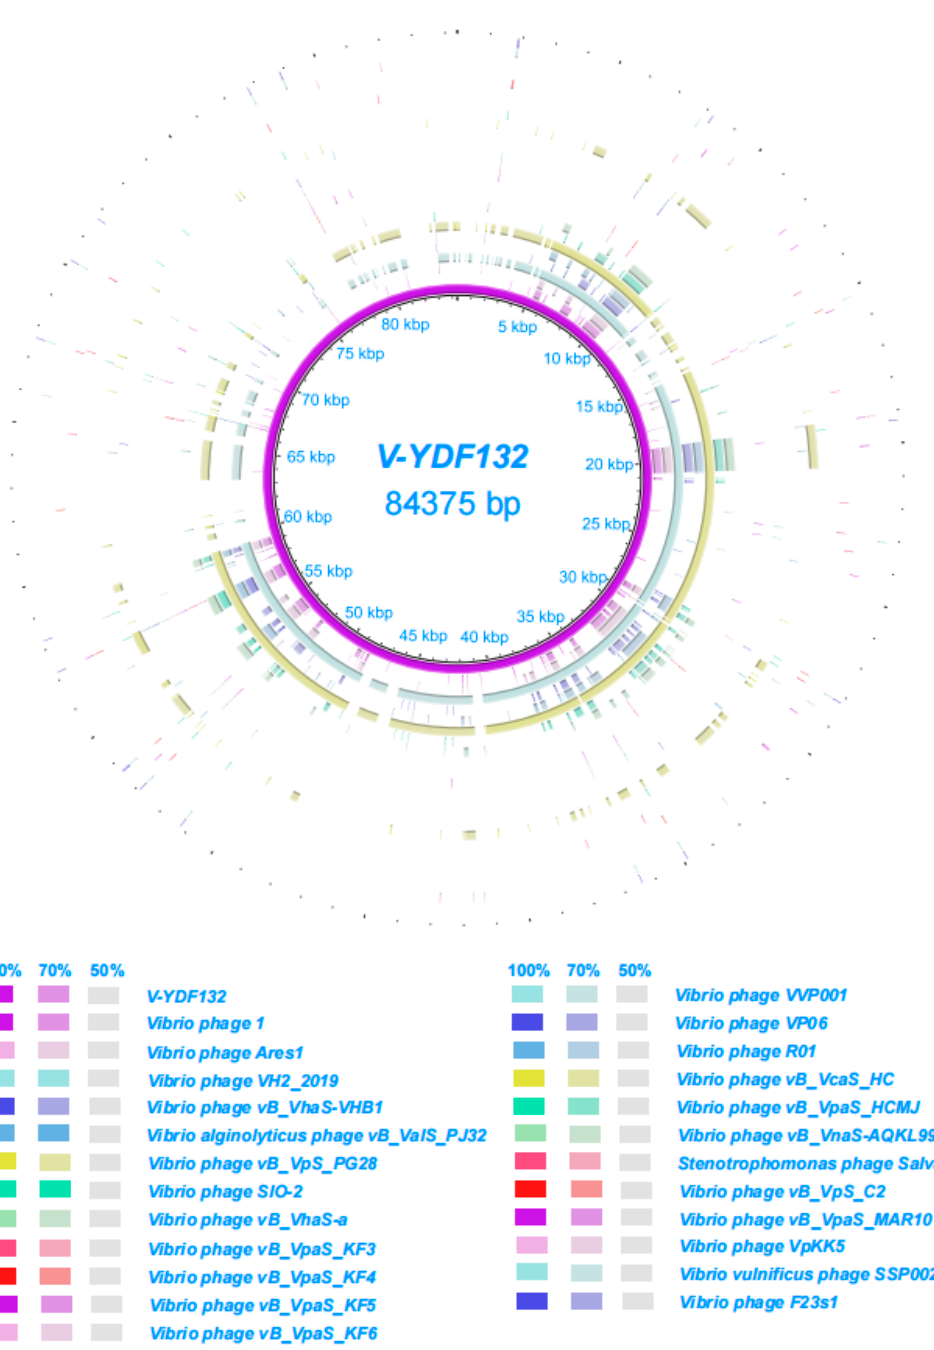
Figure 7. Circular representation depicting the complete genomic comparison of 24 other phages against V-YDF132. The first ring, in purple, represents the genome of V-YDF132. The fragments in different colors outside the purple ring indicate similar regions shared between V-YDF132 and the other 24 phage genomes based on the results from BLAST comparisons.